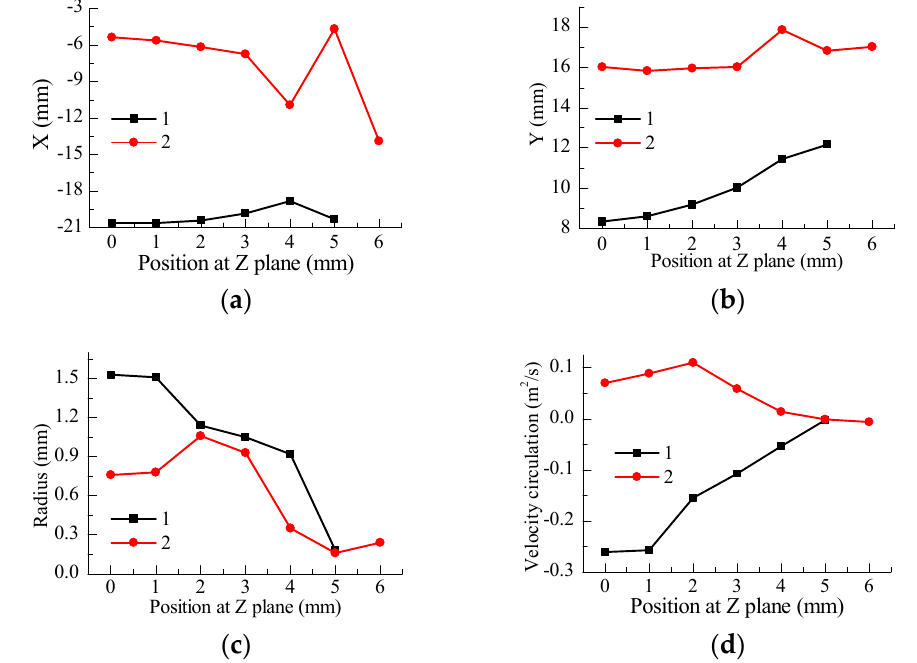
Figure 11. Position and radius of vortex at 450° BTDC. ( a ) The position of vortex center at X coordinate; ( b ) the position of vortex center at Y coordinate; ( c ) vortex radius; ( d ) velocity circulation. At 202° BTDC, the number of vortex increases rises to 6 from Z = 0 mm to Z = 6 mm, as shown